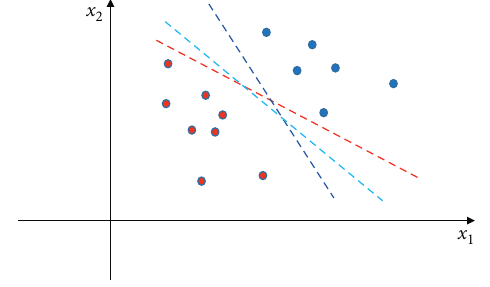
Figure 6: Example of supersets for two-dimensional space. Figure 4: Example of classifying dataset.